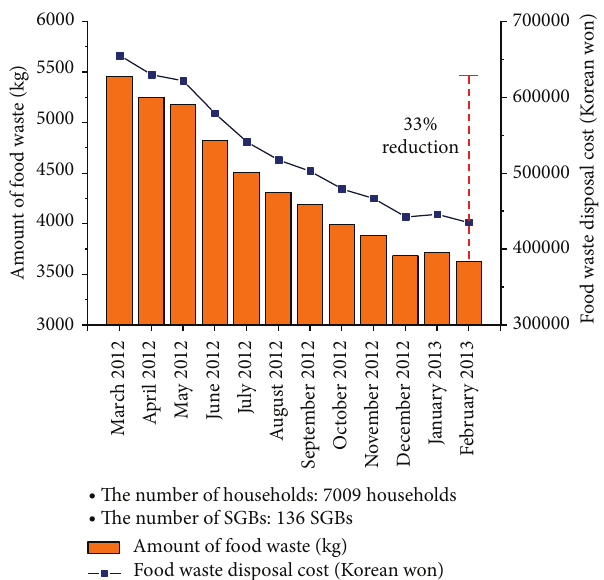
Figure 13: Amount of food waste discharged by the inhabitants of Gangnam district and disposal cost according to the amount of food waste for a one-year